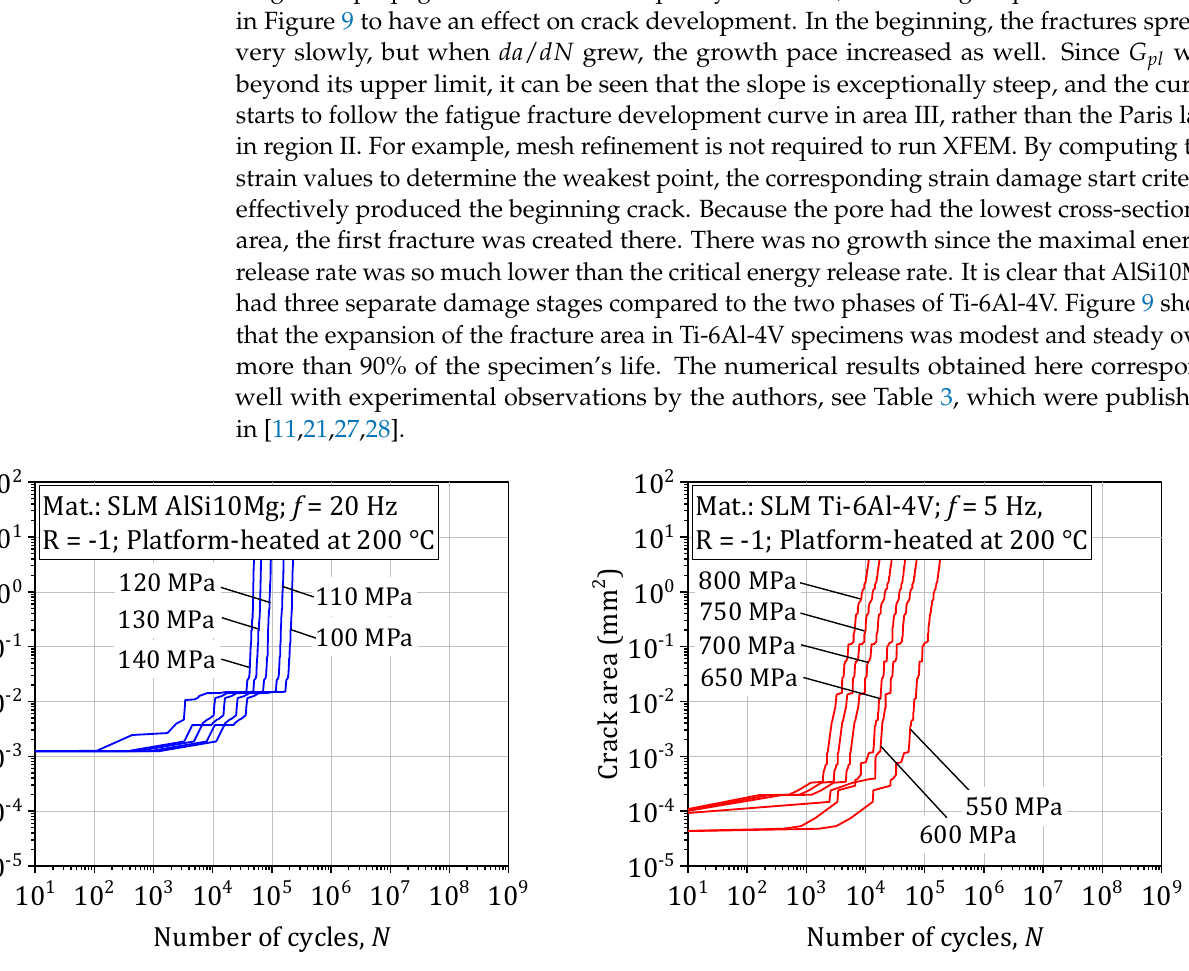
Figure 8. Influence of loading amplitude on the crack area evolution during low-frequency fatigue loading: ( a ) AlSi10Mg and ( b ) Ti-6Al-4V.